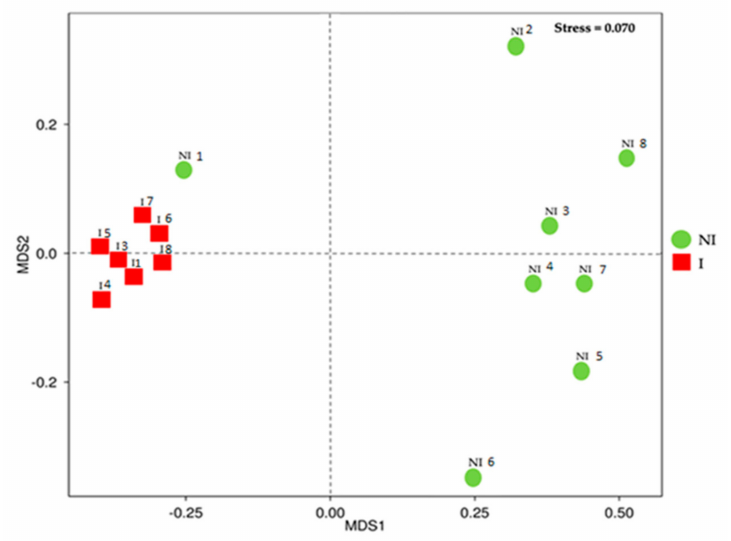
Figure 10. Non-metric Multi-dimensional Scaling (NMDS) in the skin mucus microbiota of non- infected (NI) and infected (I) European sea